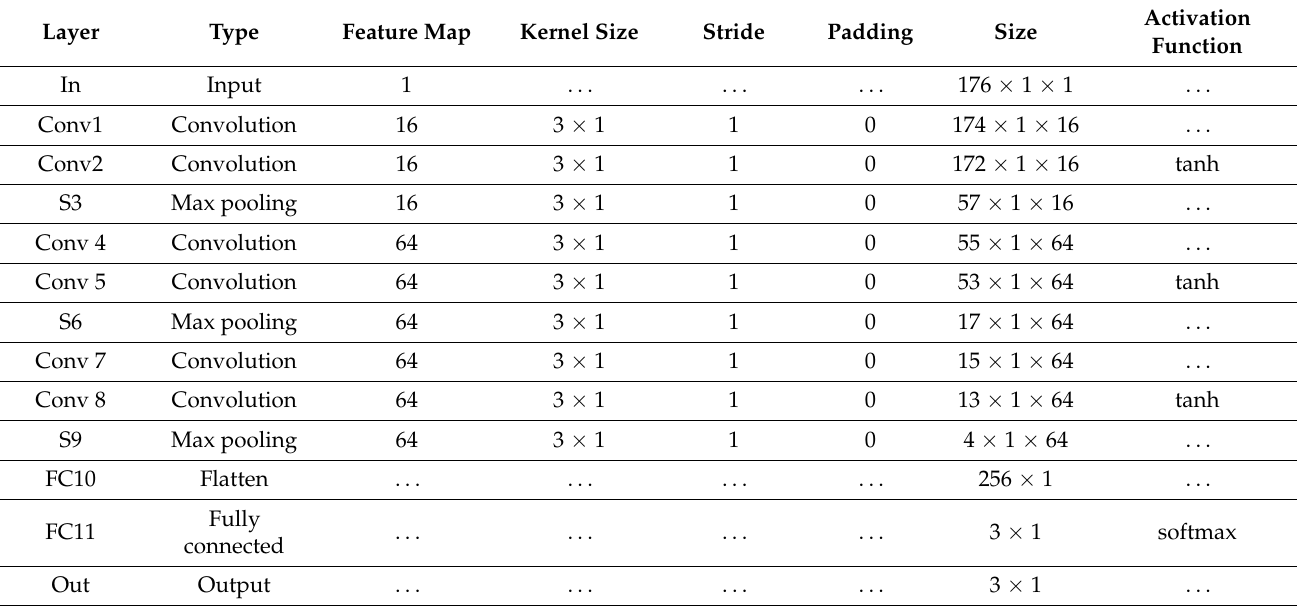
Table 2. Detailed parameters of each layer.